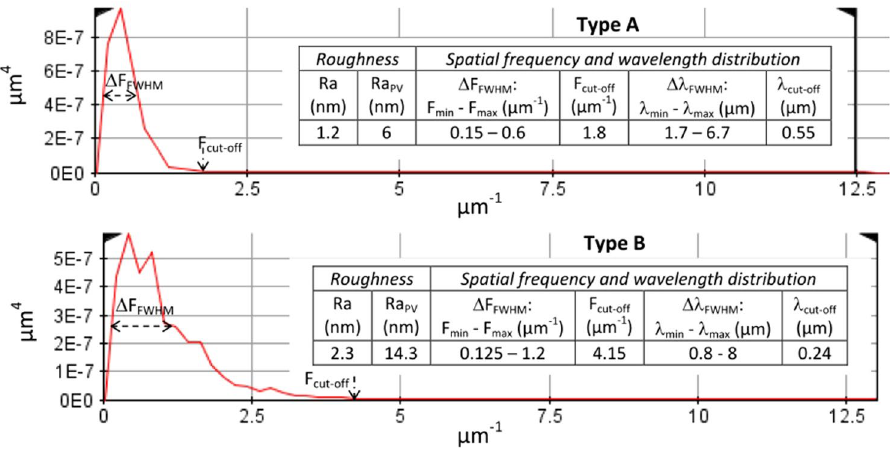
Figure 1. Surface topography of samples. Power spectral density of the surface vs spatial frequency for two Sapphire samples prepared with type A (top) and type B (bottom) methods. The tables in the insets show the parameters extracted from the PSD distribution and characterizing the surface topography of the samples. The Ra parameter is the roughness average and Ra PV the peak-to-valley roughness. Δ F FWHM (F min − F max ) and Δλ λ − λ FWHM ( min max ) respectively correspond to the extent (measured at FWHM to the peak) of the spatial frequency and wavelength bandwidth of PSD distribution of the tested surfaces. F cut-off ( λ cut-off ) informs on the high-frequency tail of the PSD distribution, specifying the highest spatial frequency (lowest spatial wavelength) present on the